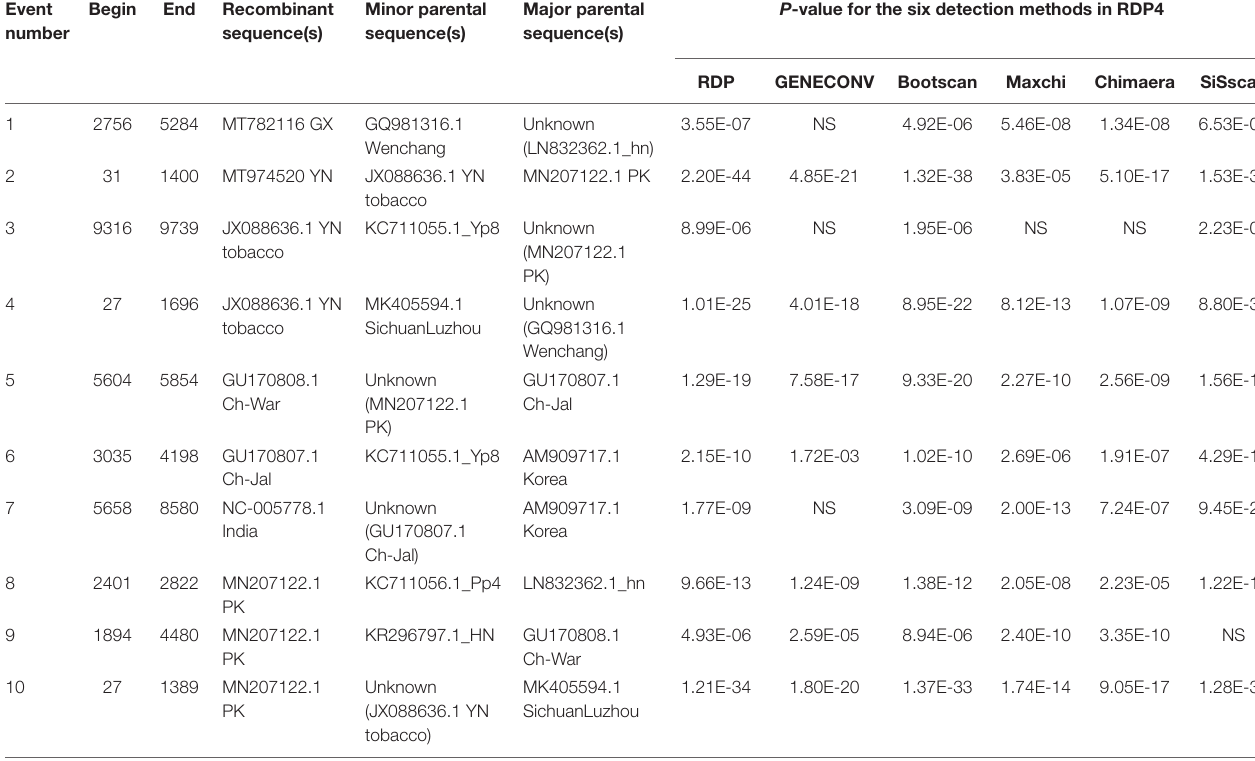
TABLE 2 | Summary of possible recombination events among 16 full-length ChiVMV isolates identified by